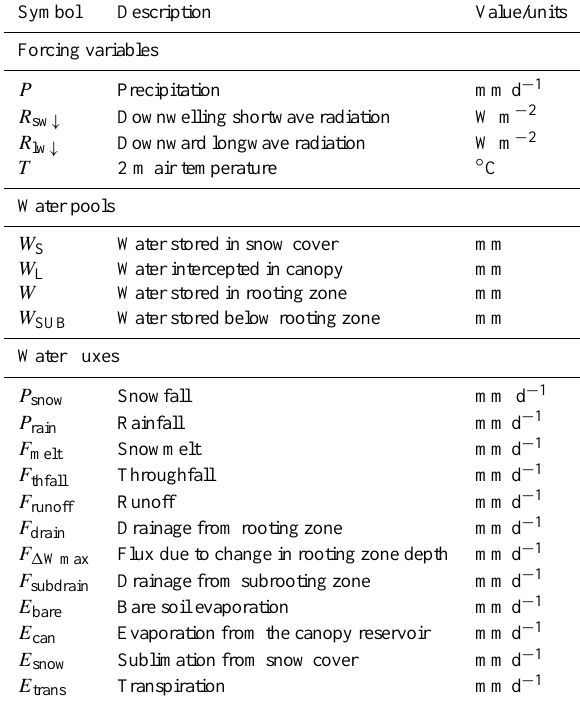
Table C6. Forcing, state, and flux variables of the land surface module.